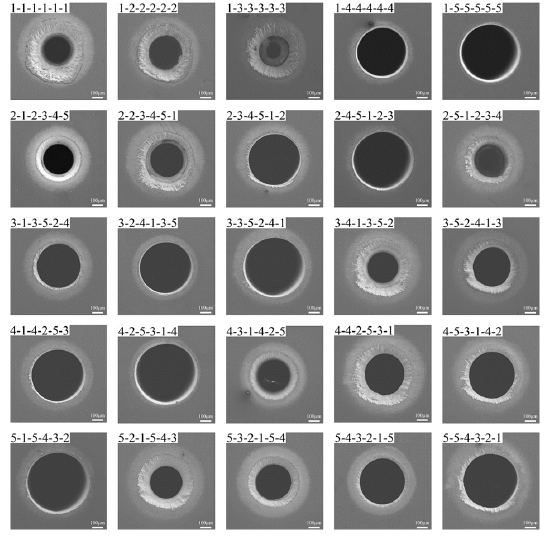
Figure 8. Morphology of femtosecond laser entrance hole.